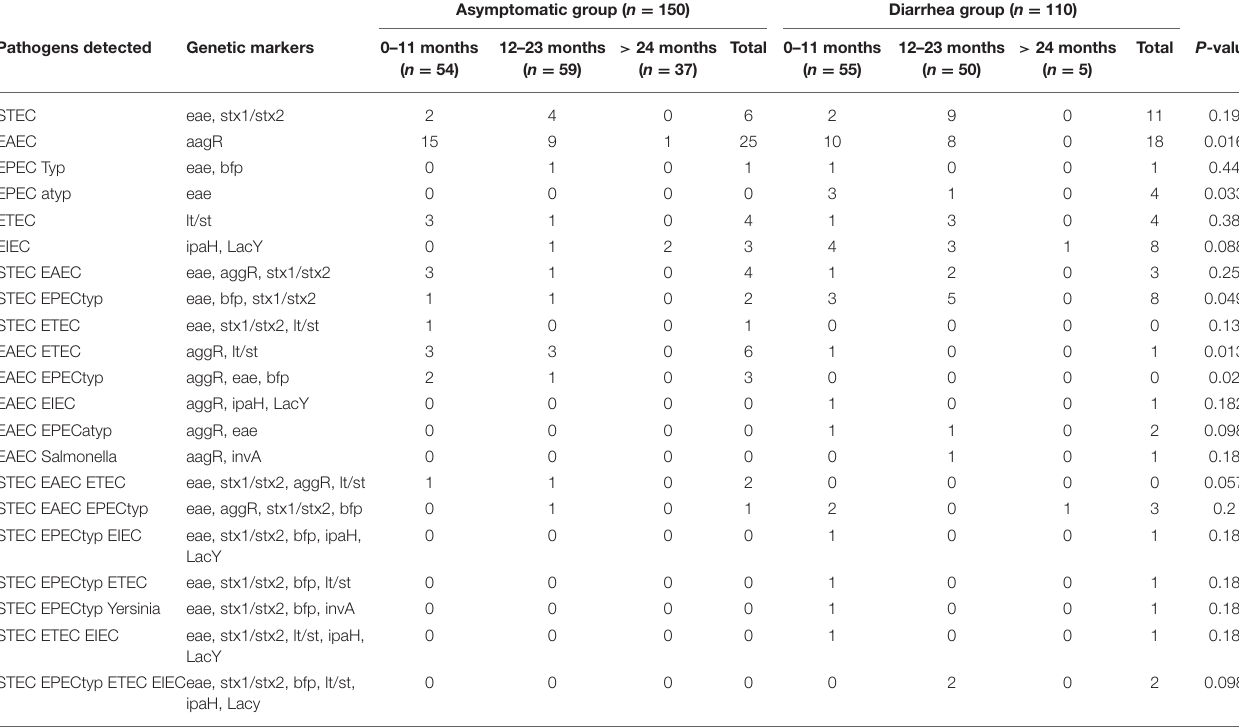
TABLE 1 | Distribution of virulence genes from enteric pathogens in fecal samples from children with and without diarrhea.